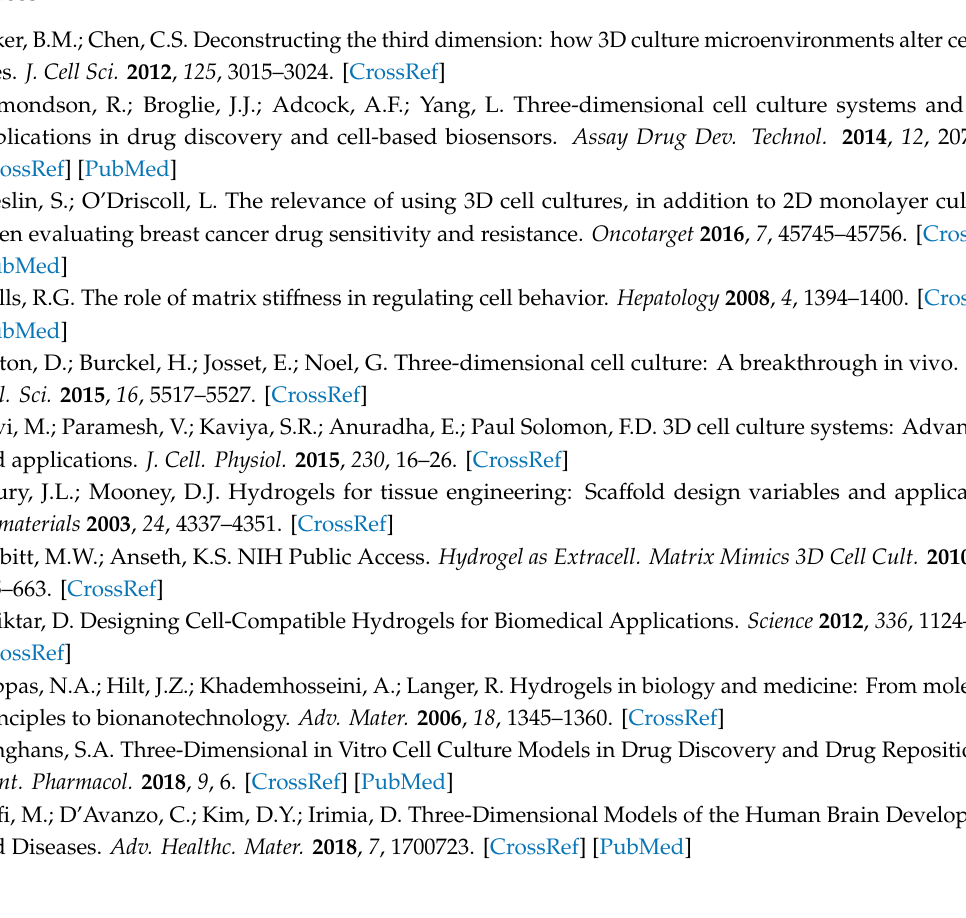
Figure S1: Representative AFM topography image of a glass surface treated with APTMS and subsequently modified with